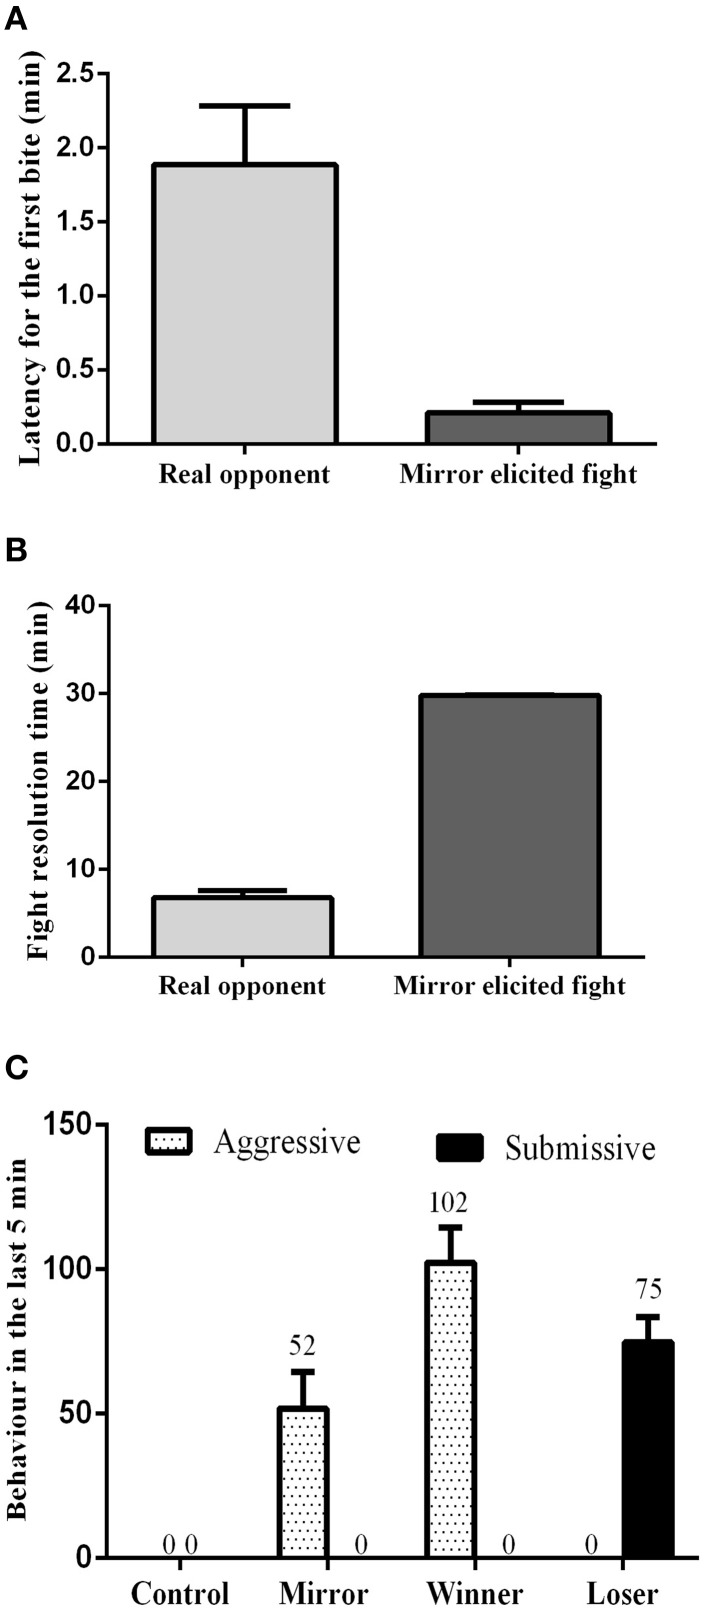
Behavioral characterization of the different social phenotypes. (A) Latency for the first bite; (B) Fight resolution time, the time required for the fight to be solved; (C) the frequency of aggressive and submissive behaviors expressed at the end of the agonistic interactions; error bars represent the standard error of the mean.